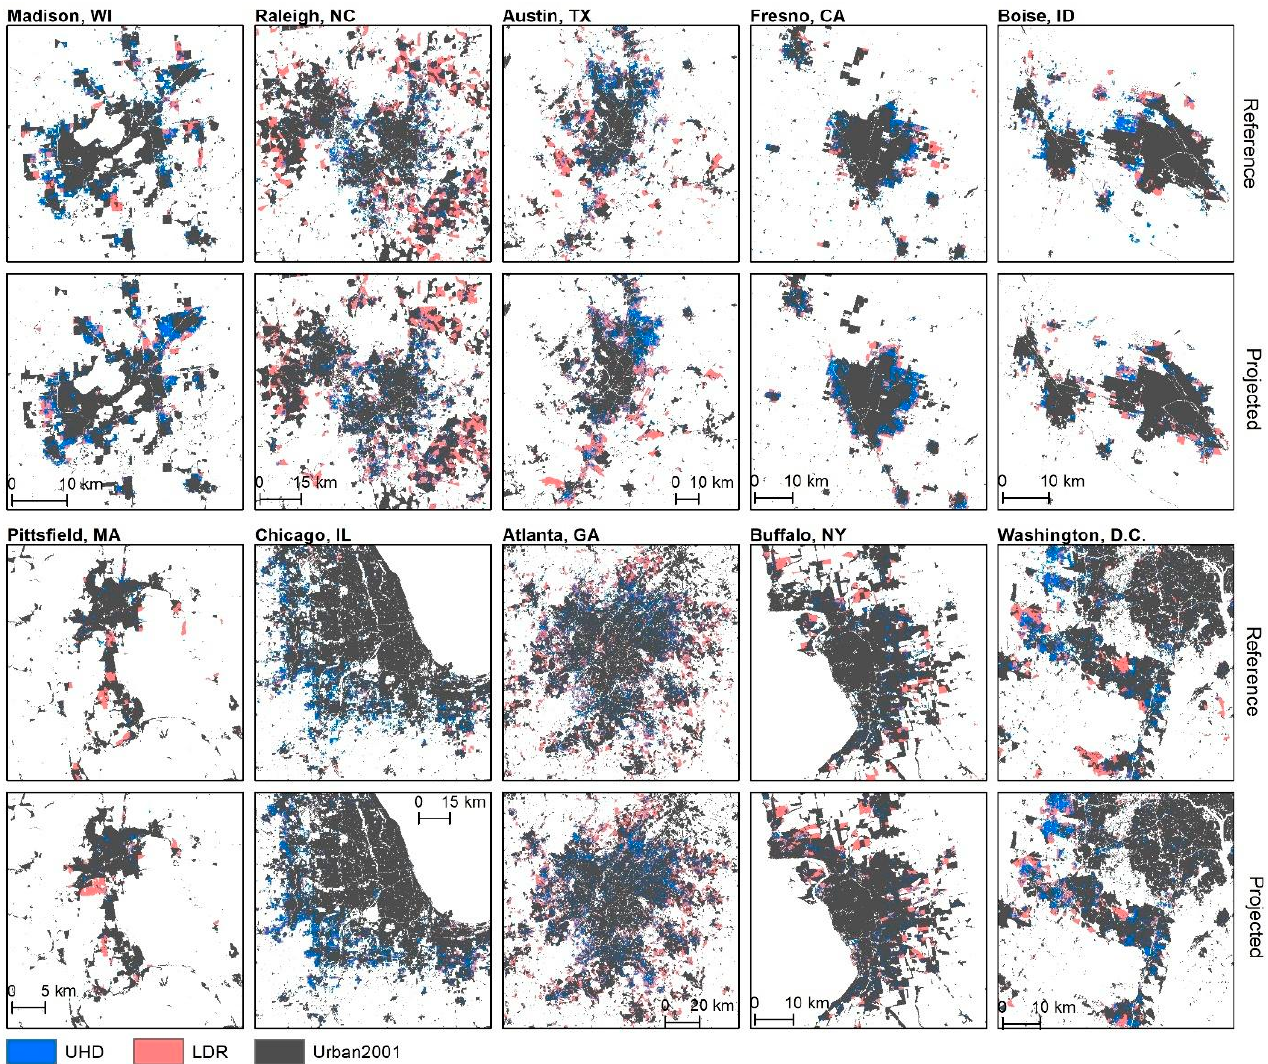
Figure 6. Comparison of projected and actual growth of urban and highly developed (UHD) and low-density residential (LDR) land use between 2001 and 2016 for 10 select cities/metropolises.